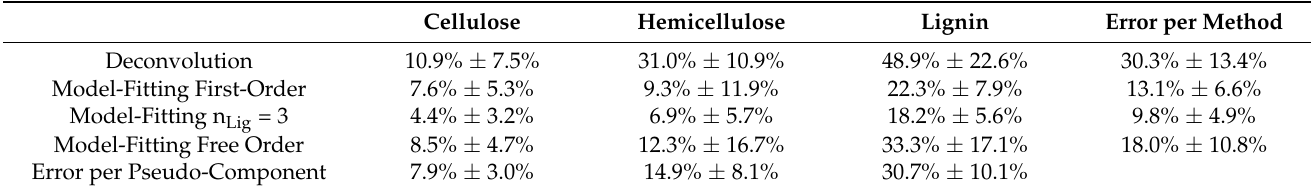
Table 7. Average absolute error of estimation of the lignocellulosic composition of a feedstock versus its reference value.